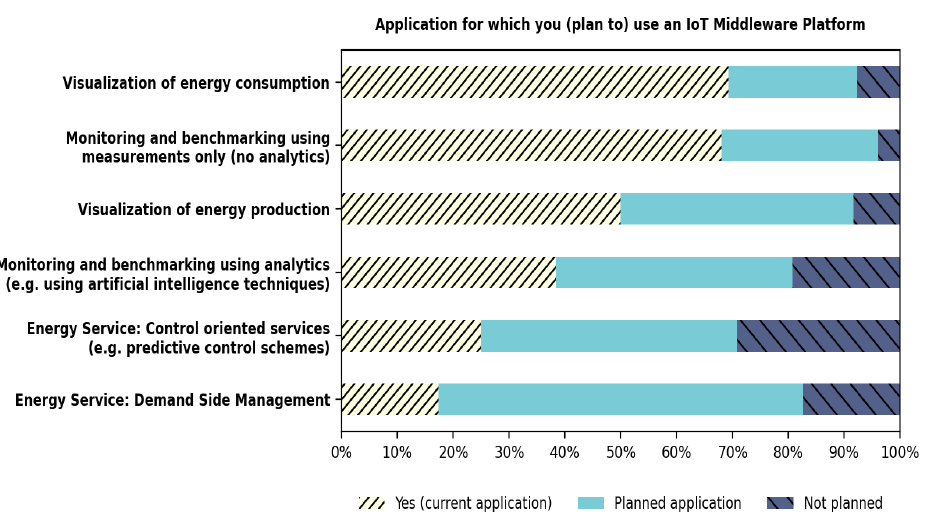
Figure 7. Responses to survey question list the applications in which the IoT middleware is used/planned to be used.